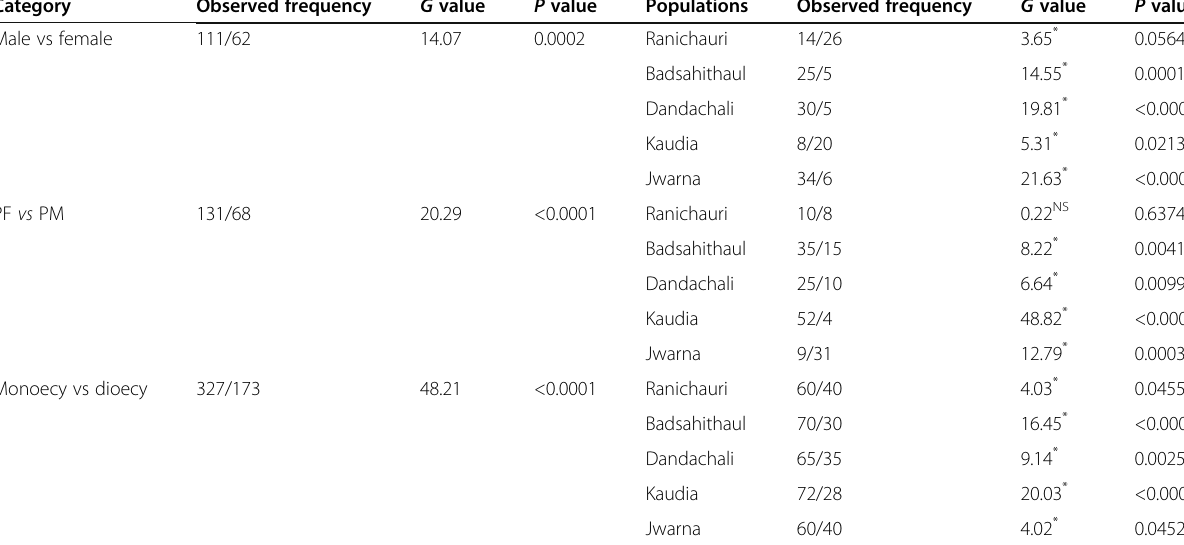
Table 3 Gender plasticity within the populations of Cedrus deodara G test (*significant, NS non-significant)